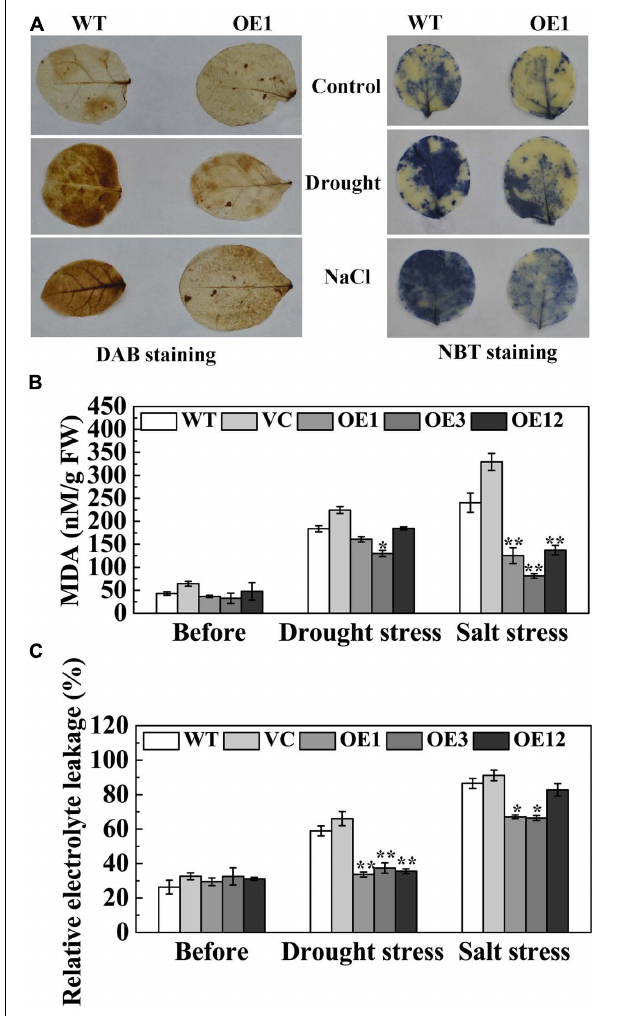
FIGURE 7 | Oxidative damage of transgenic tobacco plants after drought/salt stress. (A) Histochemical detection of H 2 O 2 and O 2 - by DAB staining and NBT staining. (B) MDA content and (C) IL under normal and drought/salt stress. Three independent biological replicates were performed and produced similar results. Vertical bars refer to ± SE ( n = 3). Asterisks indicate significant difference between the WT and the transgenic lines ( ∗ P < 0.05; ∗∗ P <